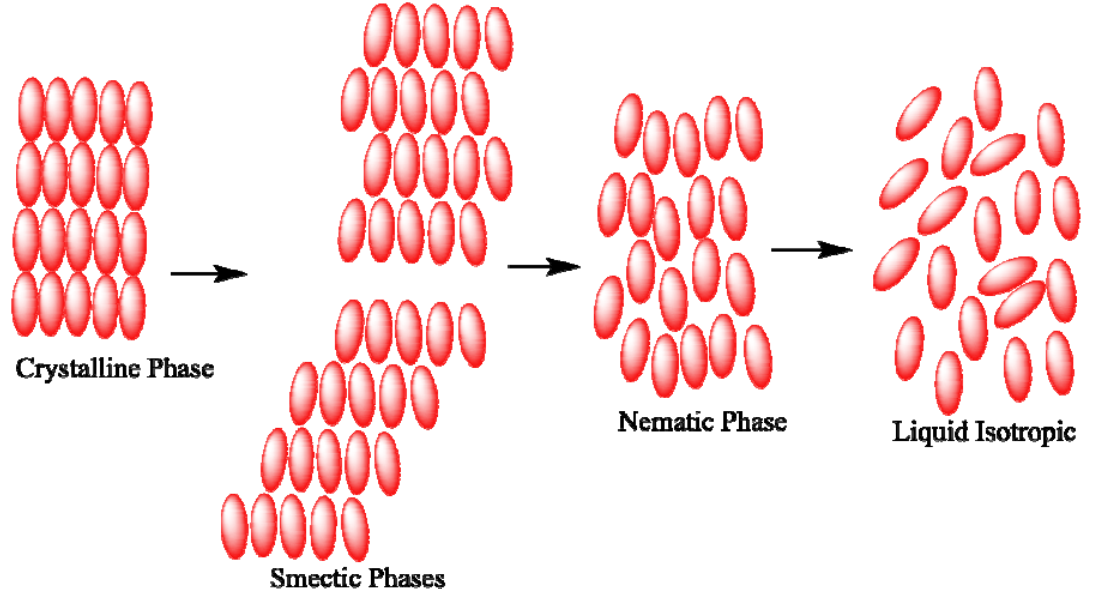
Figure 1. Phase transition between crystals, smectic, nematic, and isotropic liquid phases for a calamitic material as function of temperature.